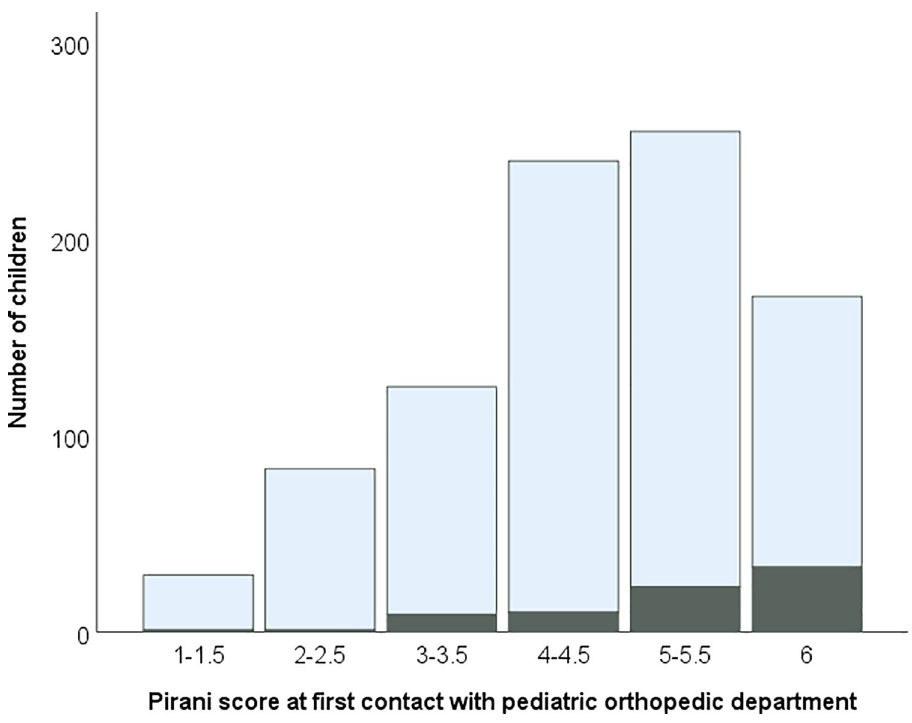
Fig 1. Pirani score at first contact with pediatric orthopedic department. The numbers of children with isolated clubfoot are shown in light blue, and children with clubfoot associated with other disease are shown in black.